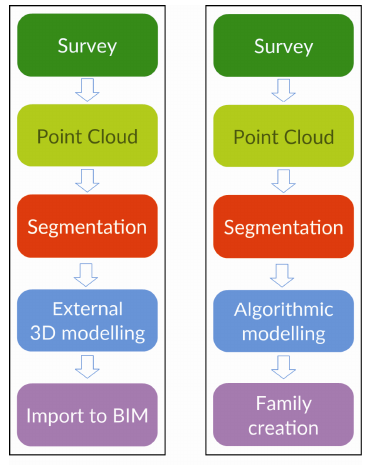
Figure 1. A comparison between the two considered geometric modeling processes in HBIM: local modeling on the left, algorithmic modeling on the